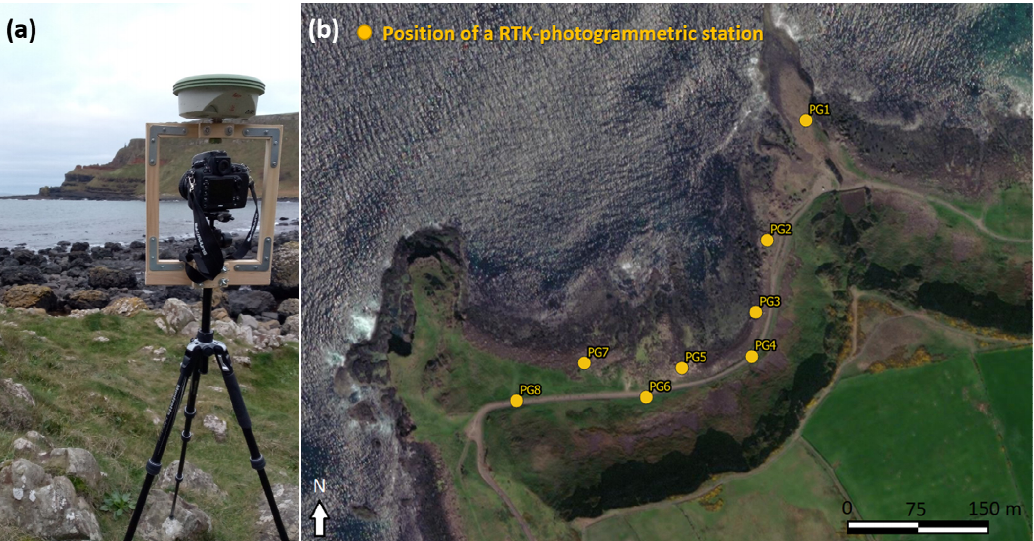
Figure 3. ( a ) Measurement system developed for the Real-Time Kinematic (RTK) Global Navigation Satellite System (GNSS)–assisted terrestrial Structure-from-Motion (SfM) photogrammetry method (equipped here with the Nikon D800 Reflex camera and the Leica 1200+ GNSS antenna). ( b ) Positions of the measured camera stations for the RTK GNSS–assisted photogrammetric survey (PG: Port Ganny stations).